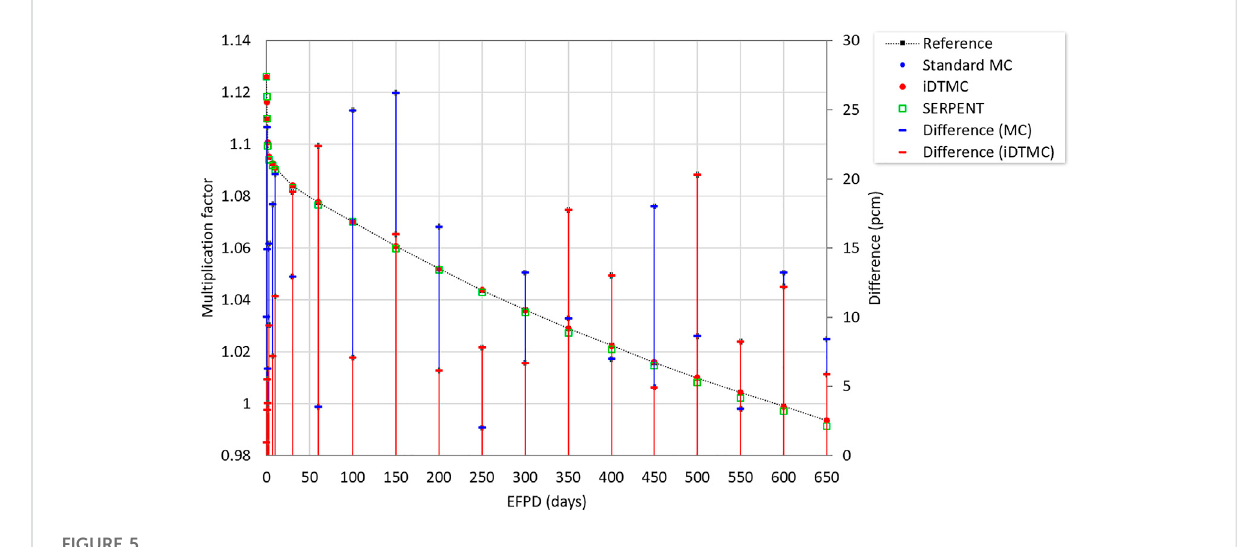
FIGURE 5 Burnup dependent criticalities of the SMR core problem.